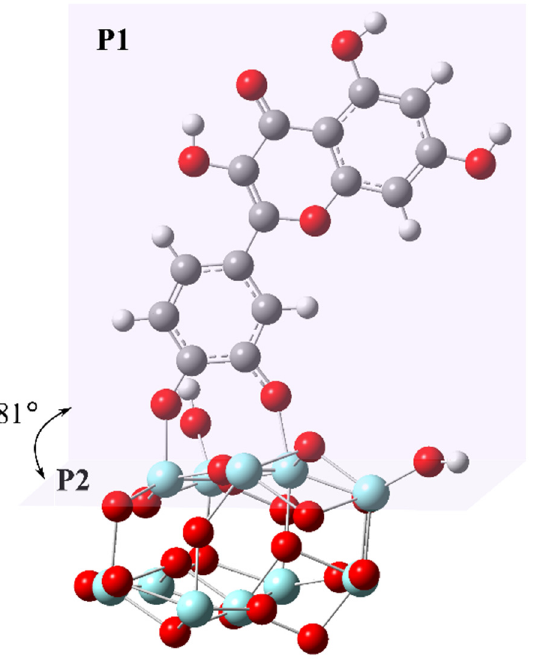
Figure 4. The optimized structure of [Zr 11 O 20 (OH) 2 ]/DHQ cluster at the CAM-B3LYP/6- 31G(d,p)/SDD(28) level of theory. The Zr, O, C, and H atoms are shown by pale blue, red, gray, and white circles. The mean planes of the coordinated DHQ molecule and (111) plane of the cluster are marked as P1 and P2 ,